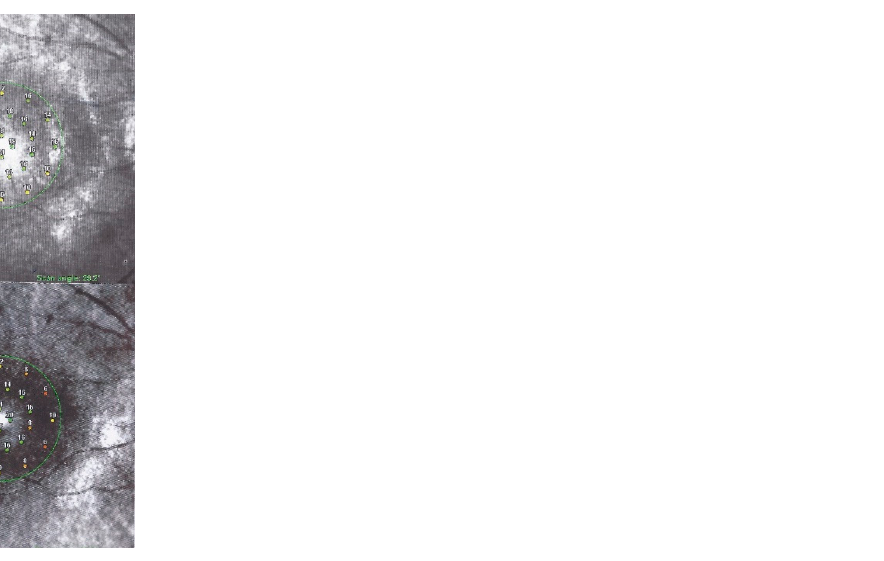
Figure 3. Visual fields OD in AZOOR patient 1. Shows tubular visual field at presentation ( A ) and increase of annular scotoma after 6 years of follow-up ( B ).